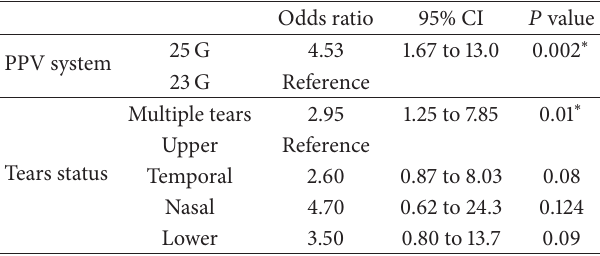
Table 4: Multiple logistic regression analysis of possible risk factors for primary anatomical